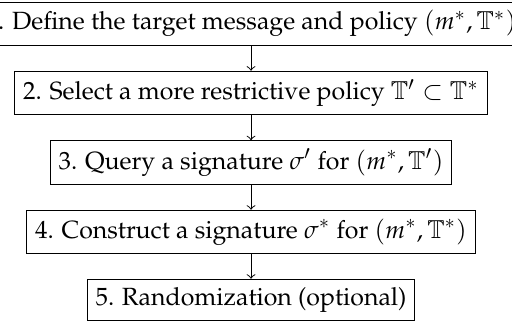
Figure 2. General steps of delegation